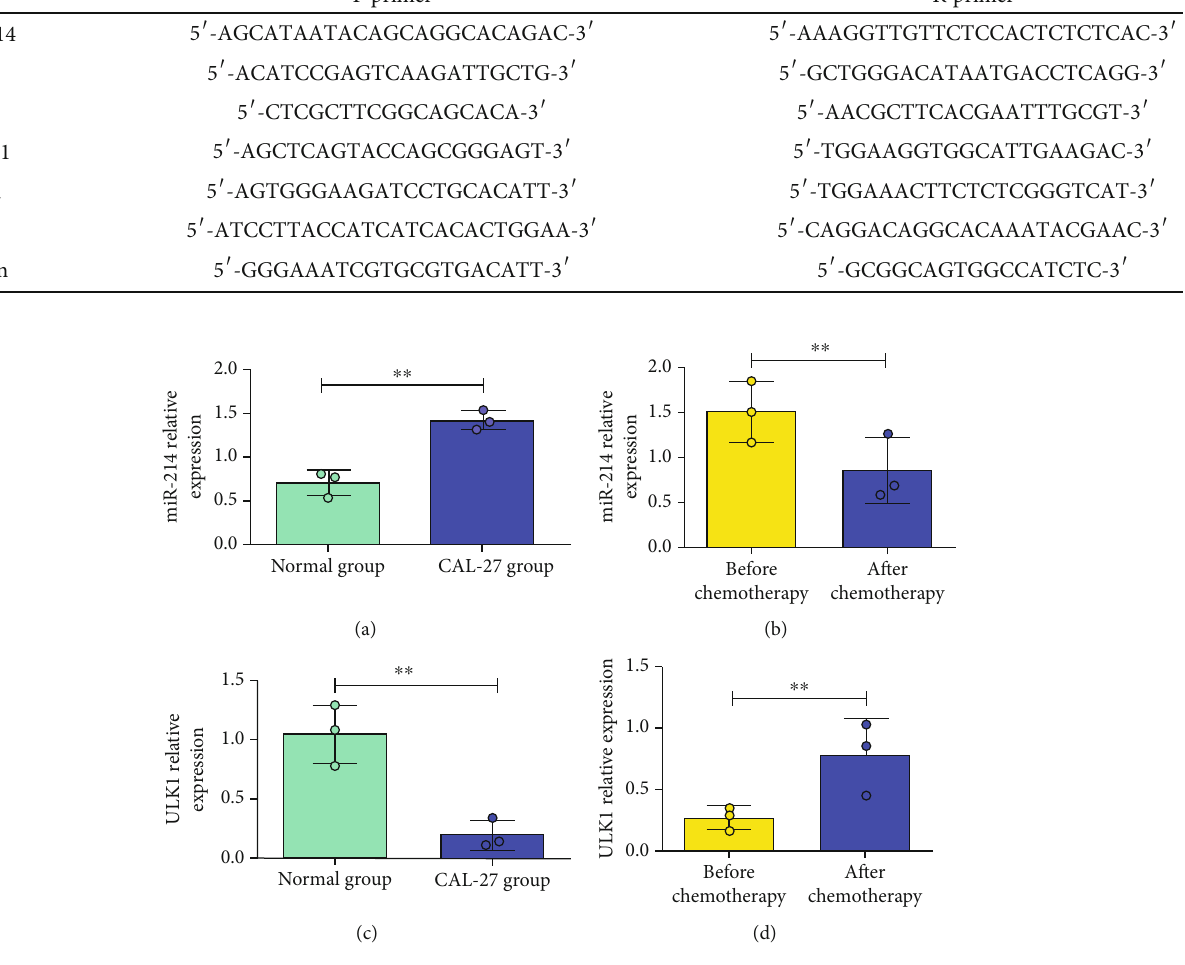
Figure 1: miR-214 and ULK1 detection by PCR. (a) Detection of miR-214 in normal oral epithelial cells and CAL-27. (b) Changes of miR- 214 level after chemotherapy. (c) Detection of ULK1 in normal oral epithelial cells and CAL-27. (d) Changes of ULK1 level after chemotherapy. ∗∗ P < 0 : 01